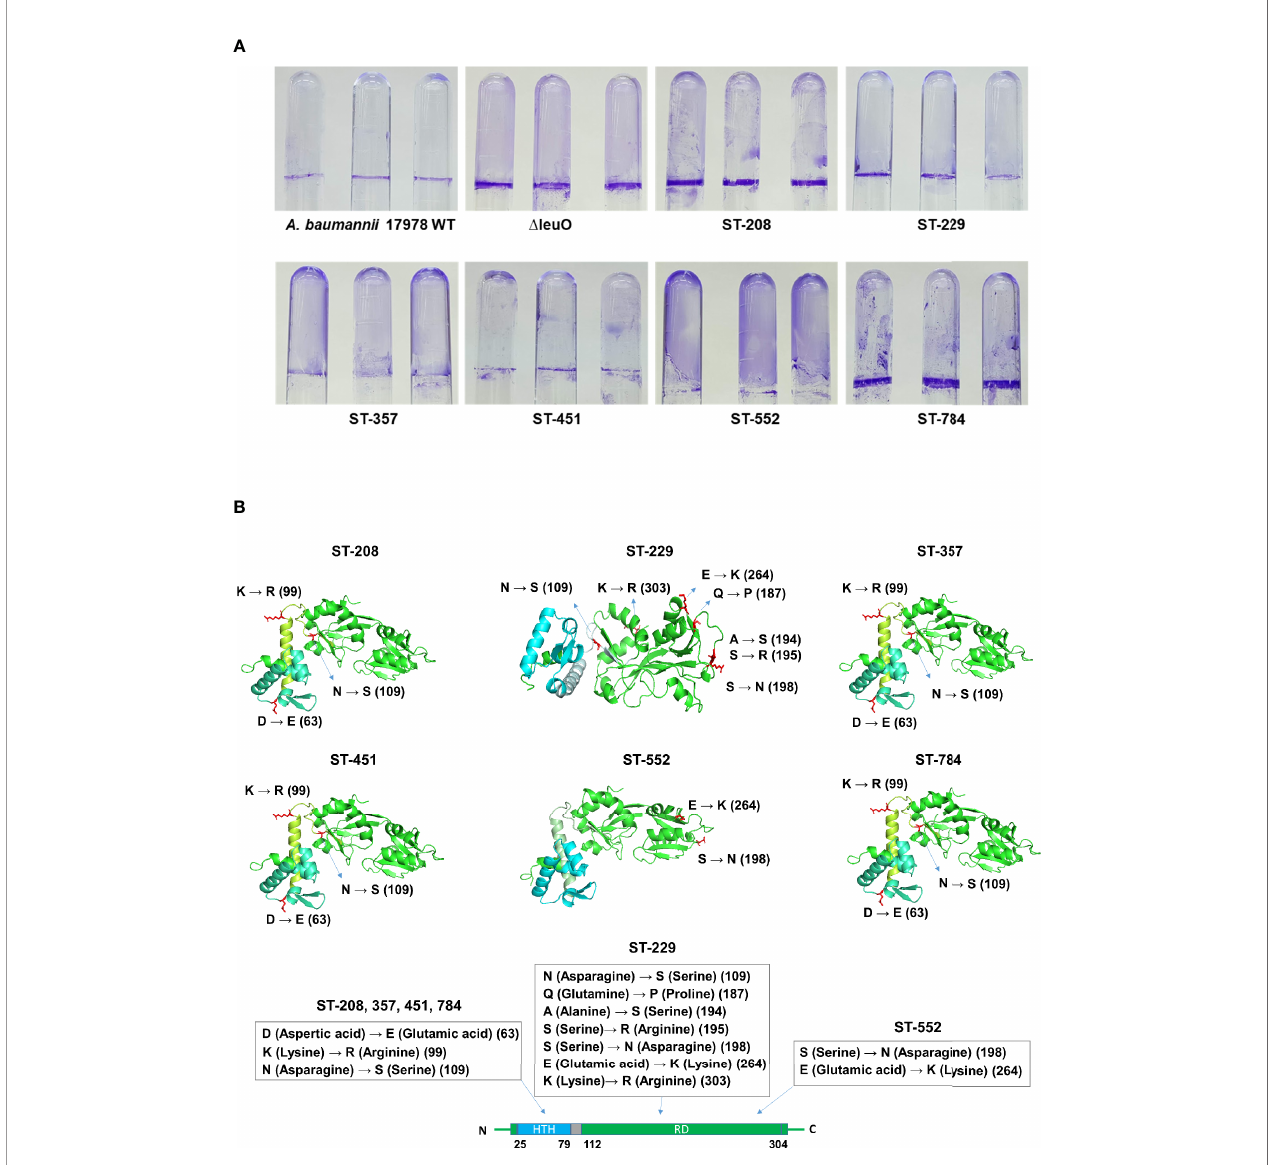
FIGURE 4 | Hyper-bio fi lm-forming clinical strains have point mutation in the LeuO gene locus. (A) A. baumannii ATCC 17978 WT, D LeuO, and clinical strains of different sequence type ST-208(011), ST-229(079), ST-357(004), ST-451(001), ST-552(015), and ST-784(001) were cultured in 5-ml polystyrene tubes at 30°C for 24 h in LB broth without salt. (A) Bio fi lm formation on polystyrene tubes was photographed after staining with 0.1% crystal violet. (B) Cartoon representations of predicted LeuO gene structures of the clinical strains ST-208, ST-229, ST-357, ST-451, ST-552, and ST-784, respectively, obtained using the PyMoL software. Blue color indicates the N-terminal HTH domain, and green color indicates the C-terminal regulatory domain. Mutated residues are shown in red sticks at different positions such as 63, 99, 109, 187, 194, 195, 198, 264, and 303 and are marked